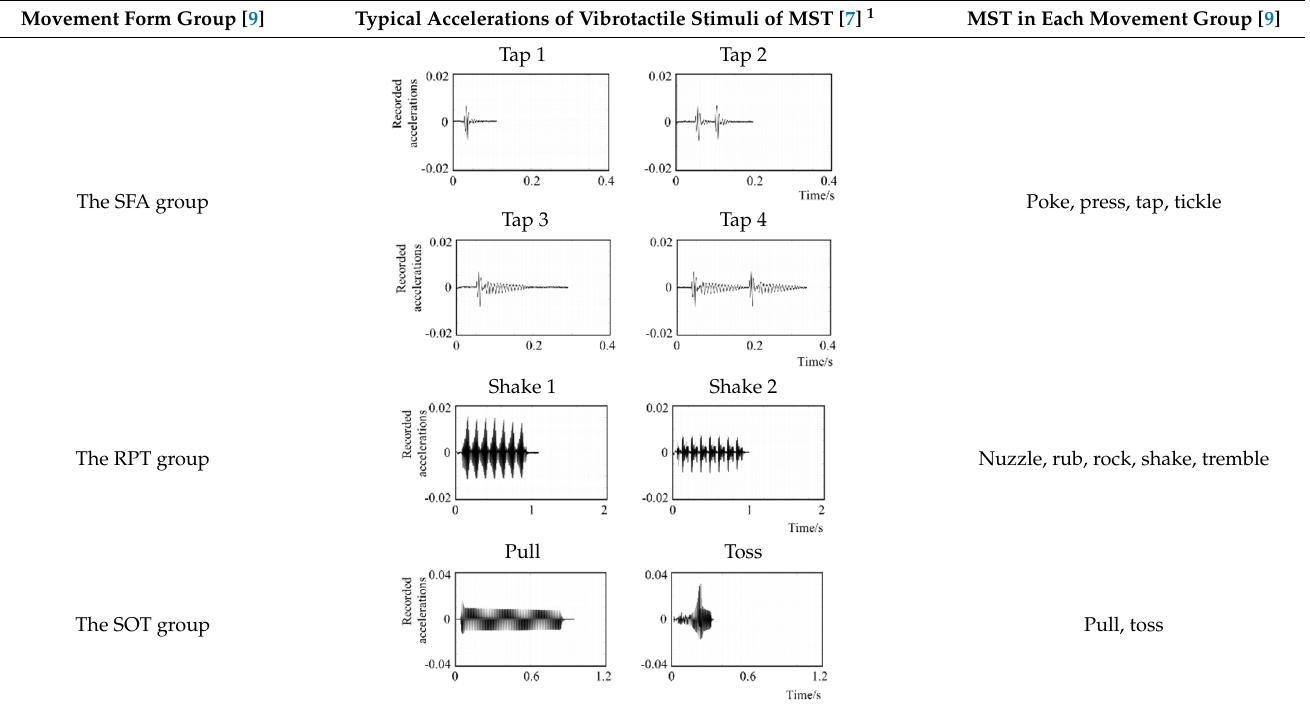
Table 1. Properties of vibrotactile stimuli for MST in each movement form group.